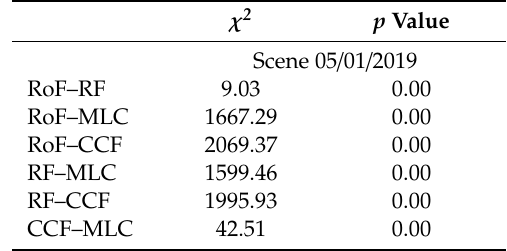
Table 6. McNemar test comparing the performance of selected models in prediction of seagrass class.